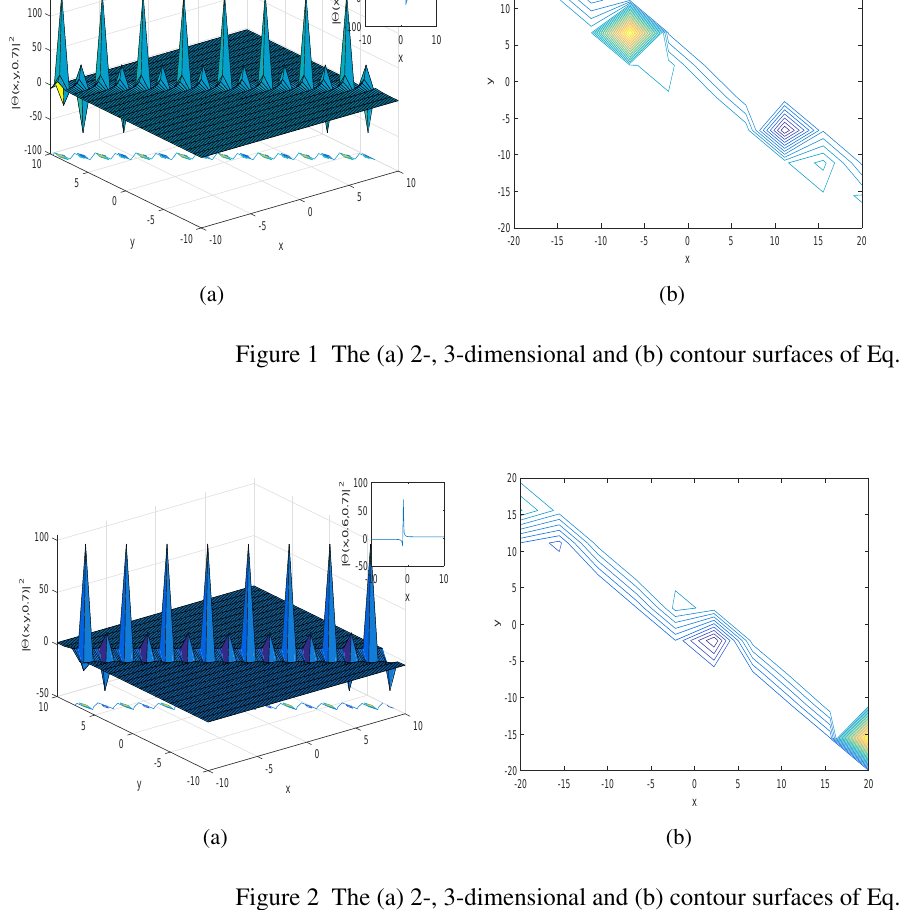
Figure 2 The (a) 2-, 3-dimensional and (b) contour surfaces of Eq.